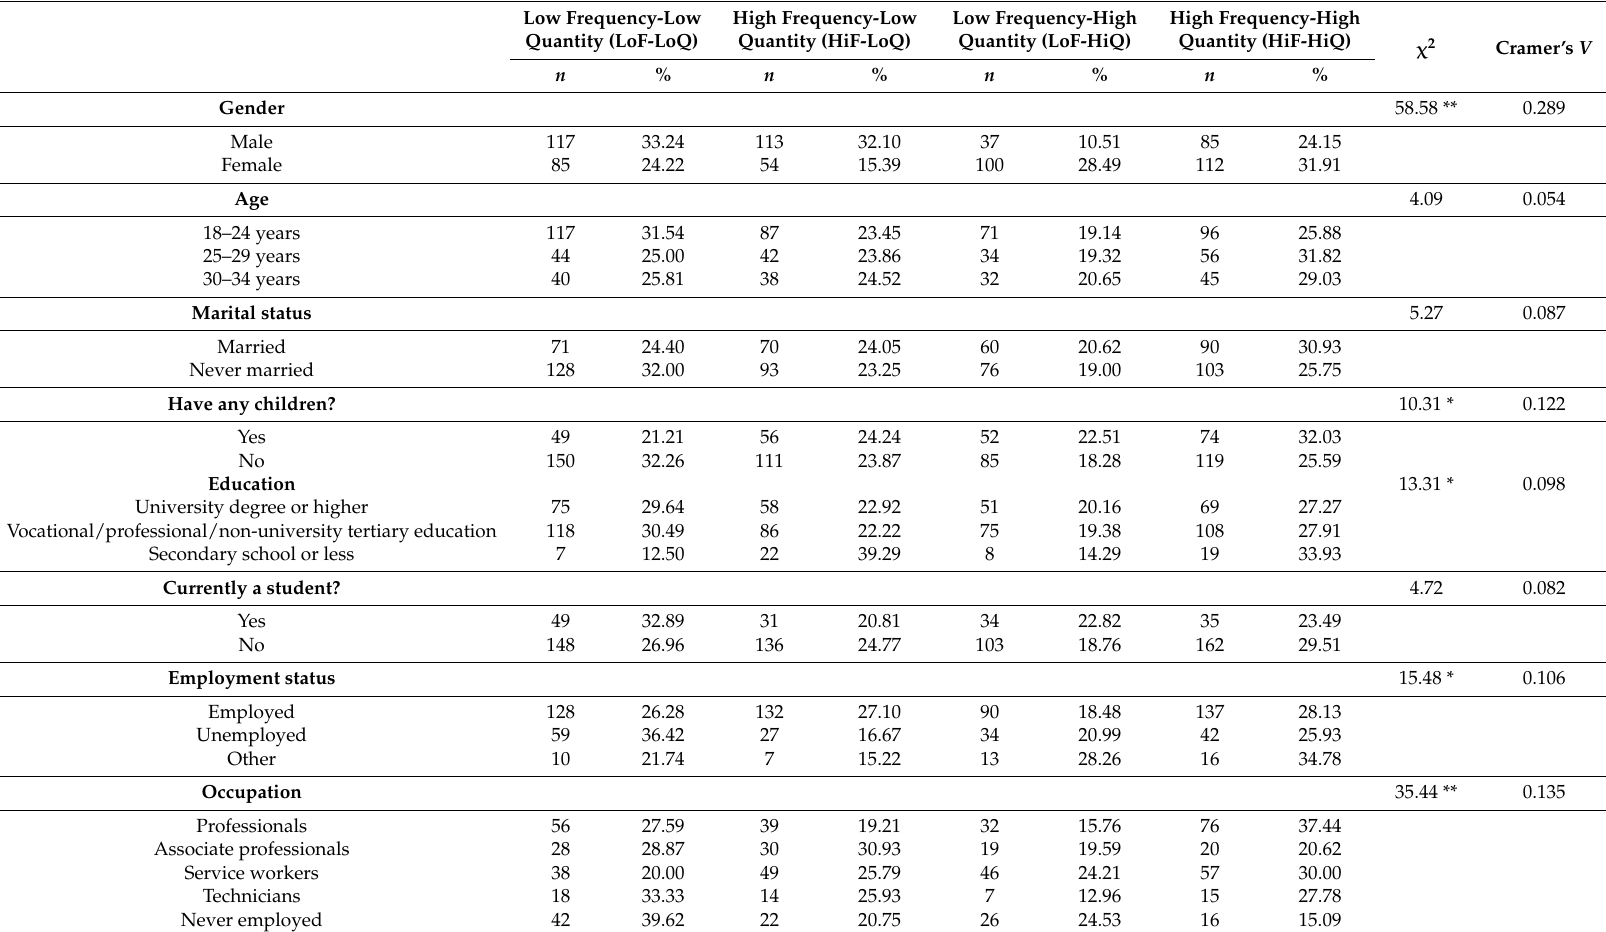
Table 4. Demographic descriptions by drinking frequency-quantity